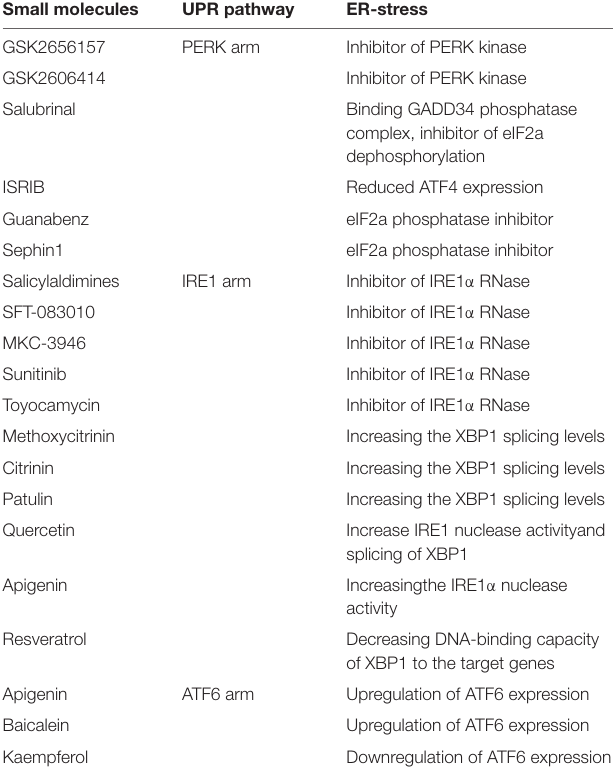
TABLE 1 | Pharmacological targeting of UPR pathway (Rivas et al., 2015; Hetz et al.,